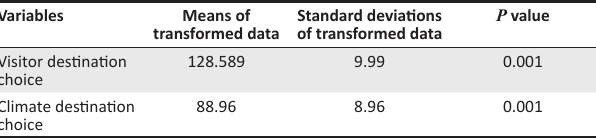
TABLE 8: Bartlett’s test for homogeneity of variances. Variables Means of Standard deviations transformed data of transformed data